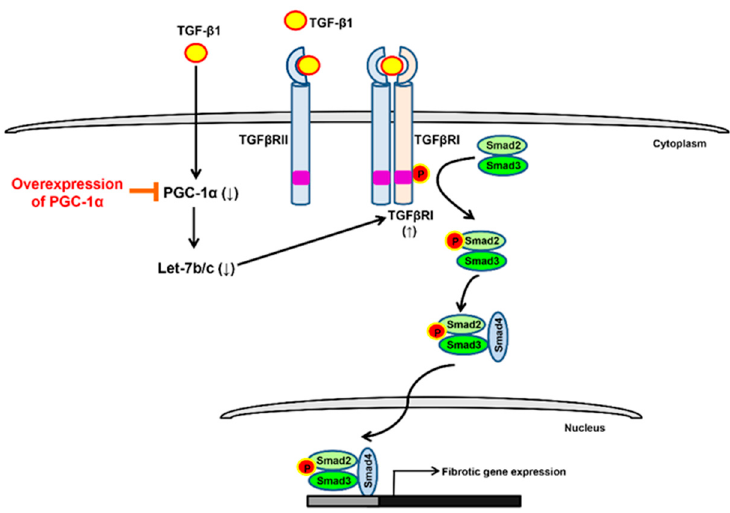
Figure 7. Regulation of let-7b / c / TGF β RI / Smad2 / 3 axis by PGC-1 α . Treatment of TGF- β in human proximal tubule epithelial cells lowers the expression of PGC-1 α and negatively regulates the expression of its downstream miRNA, let-7b / c . Downregulation of let-7b / c increases the expression of TGF β RI, which induces phosphorylation of TGF β RI by TGF- β treatment and subsequently increases the activity of Smad2 / 3. As a result, the EMT-related gene expression is increased and the EMT progression proceeds. The targeting strategy of the let-7b / c / TGF β RI / Smad2 / 3 axis by overexpression of PGC-1a is proposed as one of the therapeutic targets that inhibits EMT progression.